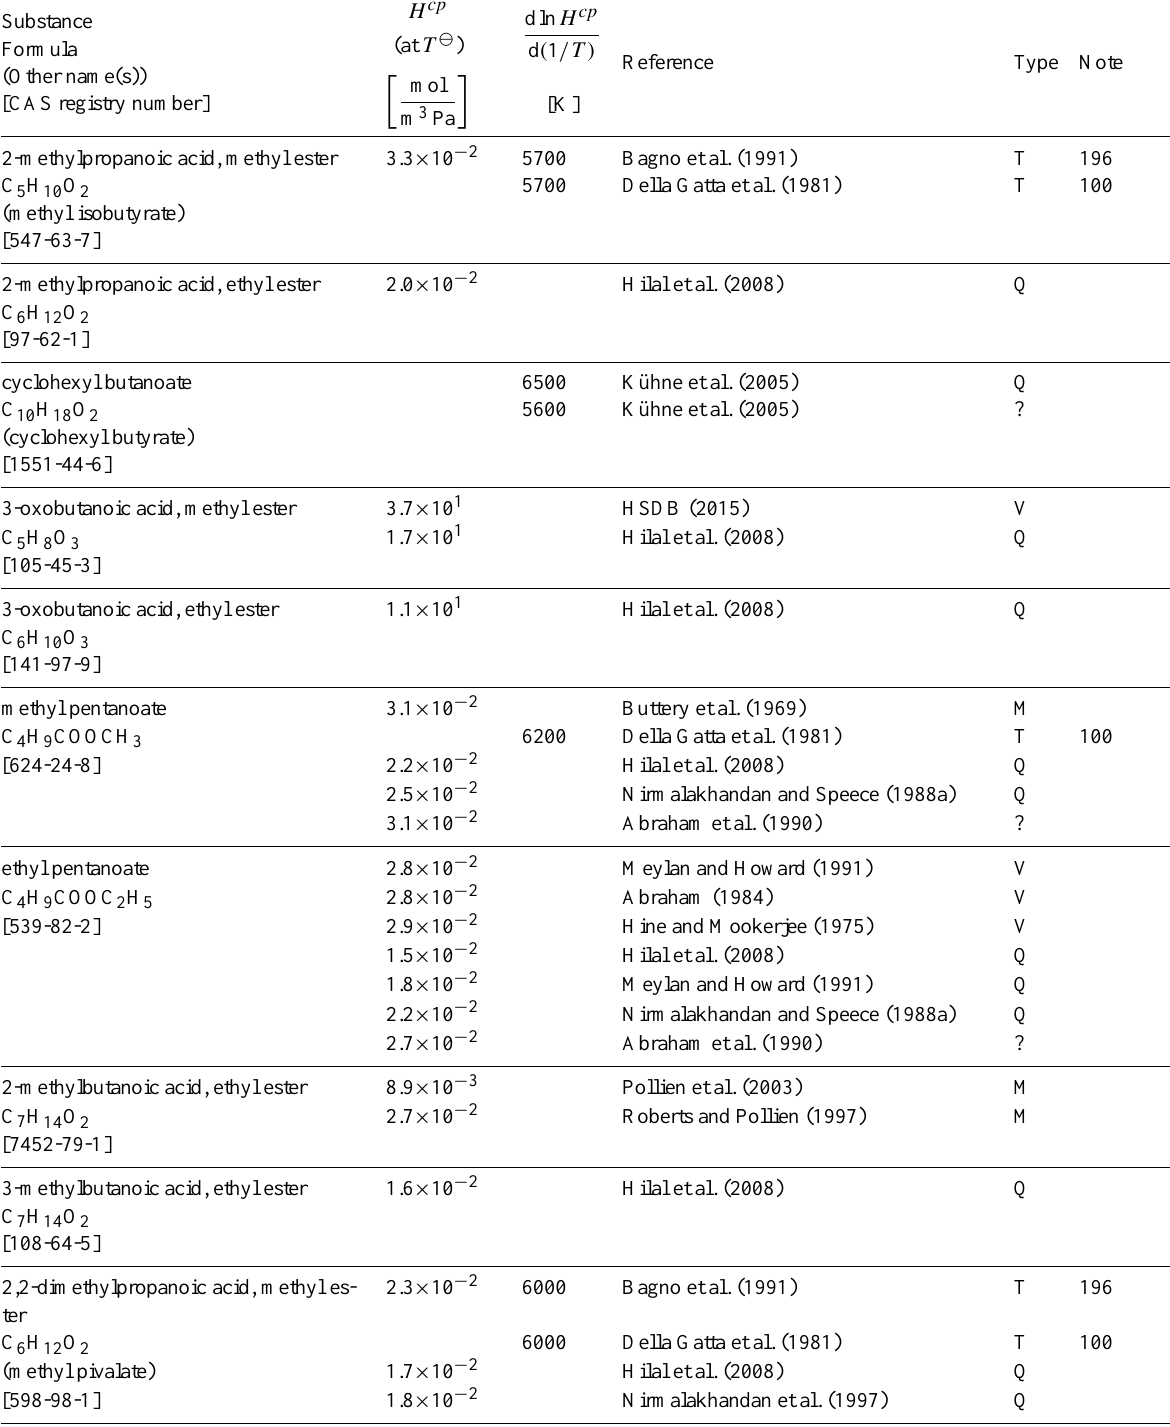
Table 6: Henry’s law constants for water as solvent